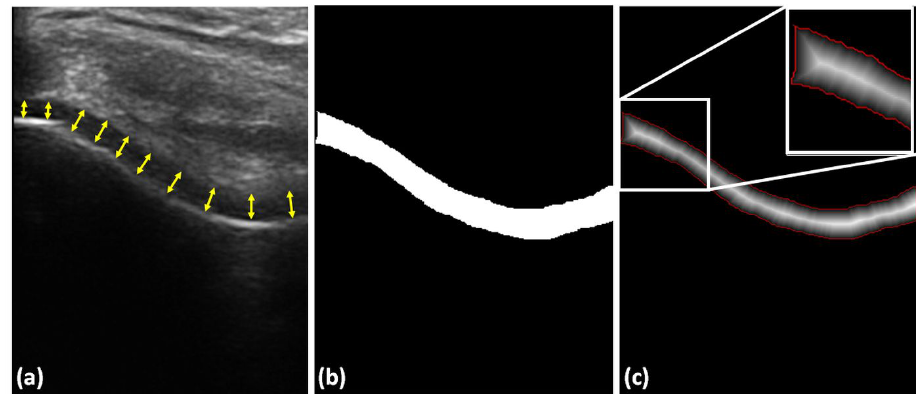
Figure 6. Cartilage-thickness measurement. ( a ) Example manual thickness measurement using 10 anatomical landmarks obtained by drawing a normal line between cartilage–bone interface and the synovial space, shown with yellow arrows. ( b ) Automatically segmented cartilage. ( c ) Distance map obtained from the segmented image shown in ( b ). Red pixels, cartilage boundary, used during the calculation of mean cartilage thickness. White rectangle, zoomed-in region for improved display.